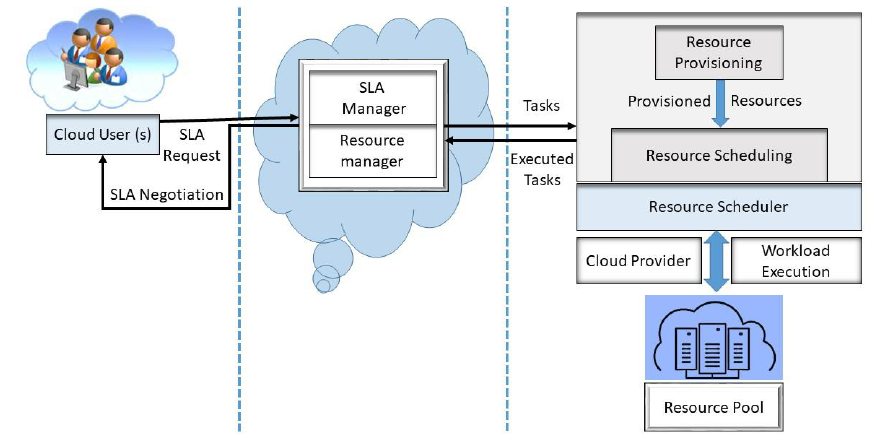
Figure 2. Proposed PRP-RM-SLA model.